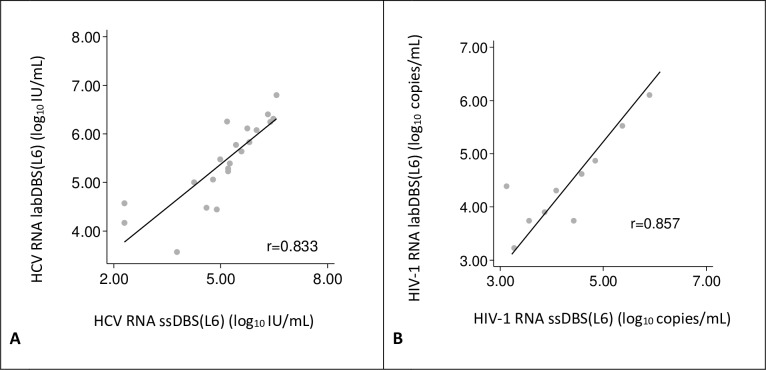
Correlation between self-sampled dried blood spots (ssDBS) and lab-sampled dried blood spots (labDBS) viral load measurements.Individual viral load measurements are plotted (gray dots). The solid line indicates the linear regression line between the two samples. (A) HCV loads. The linear relationship between the samples is defined as: log10 IU/mL labDBS HCV = 0.595 x (log10 IU/mL ssDBS) + 2.402. (B) HIV-1 loads. The linear relationship between the samples is defined as: log10 copies/mL labDBS HIV-1 = 0.833 x (log10 copies/mL ssDBS) +0.857.